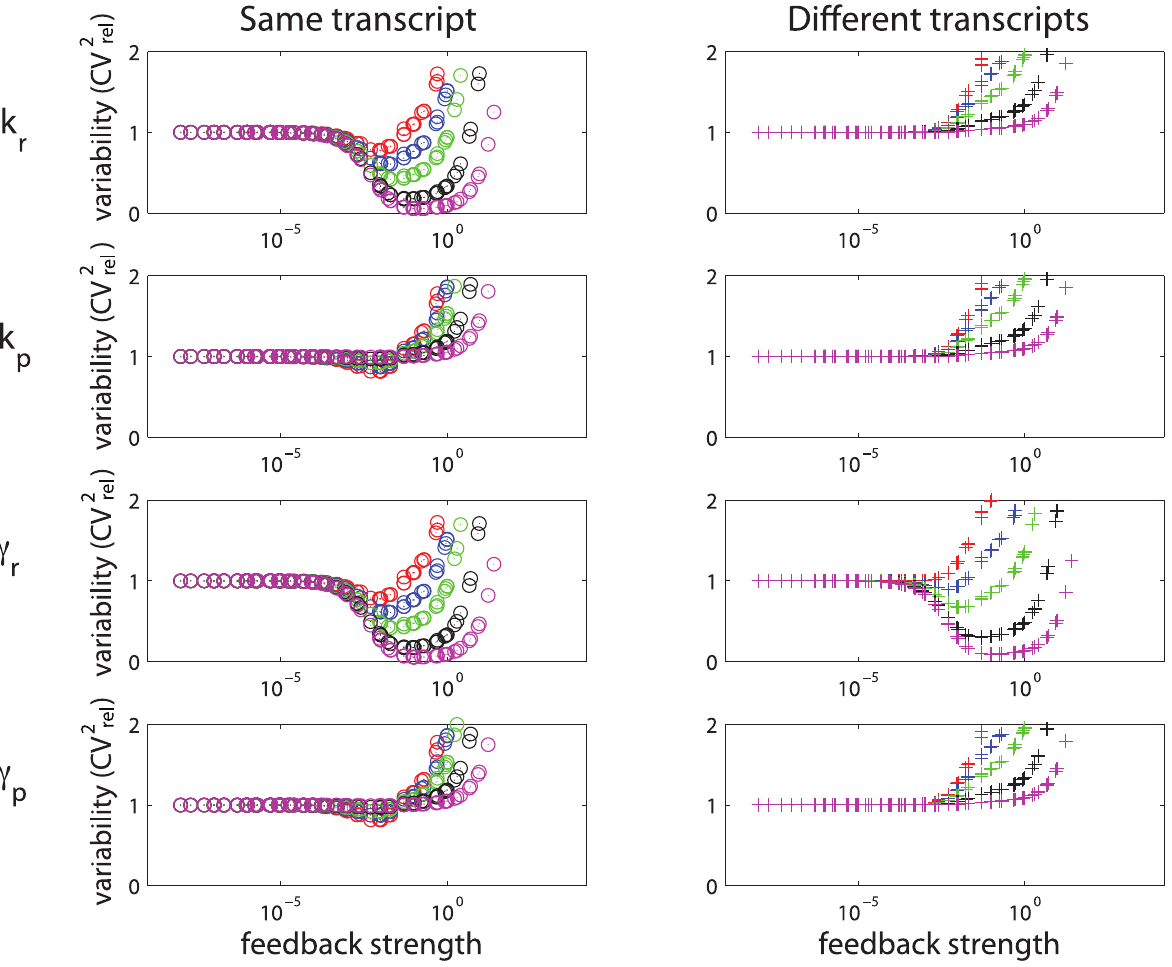
Figure 9. Comparison of total protein variability in circuits with mRNA and miRNA on the same (o) or different ( + ) transcripts. Extrinsic variability in parameters (eqn. (13)): a ~ 0 : 01 (red), a ~ 0 : 03 (blue), a ~ 0 : 05 (green), a ~ 0 : 1 (black), and a ~ 0 : 2 (magenta). Feedback strength is k on = ( k off z c r (cid:2) ) .